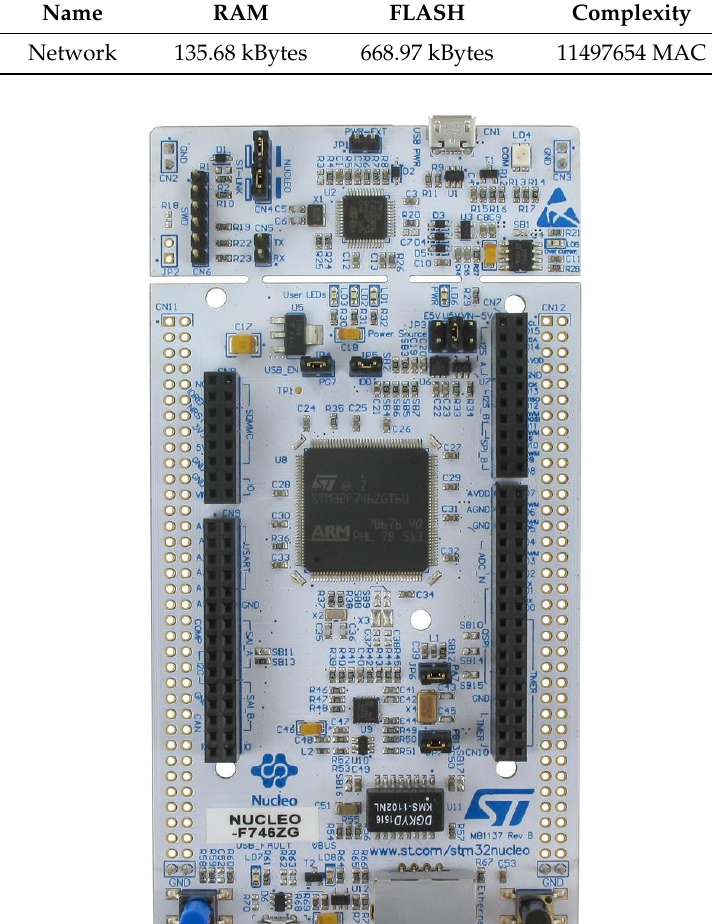
Table 6. Prediction of model on hardware.